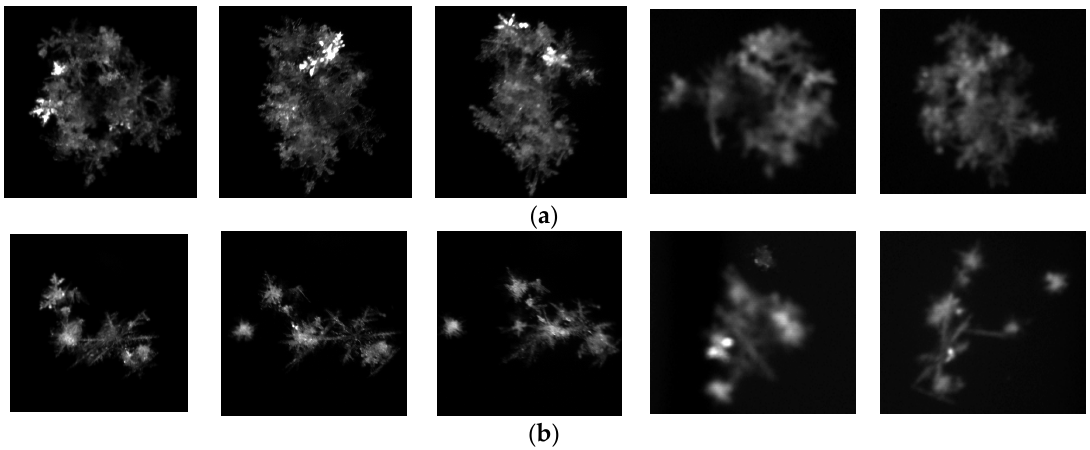
Figure 4. Two sets, ( a ) and ( b ), of five images of two snowflakes collected by five cameras of the new five-camera MASC system during the snow storm on 15 November 2014, at the MASCRAD Field Site. In each horizontal panel, ( a ) or ( b ), images 1–3 are taken by the three original “internal” MASC cameras, while images 4–5 are taken by the two additional “external” cameras of much lower resolution (but sufficient for the visual hull 3D shape reconstruction method).